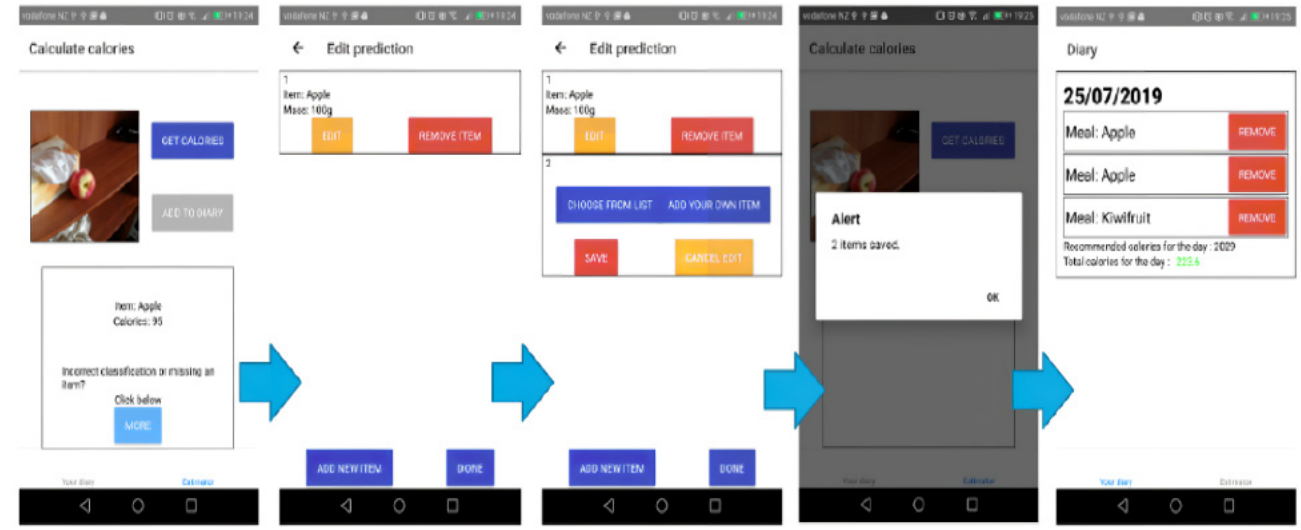
Figure 9. Mobile application results.